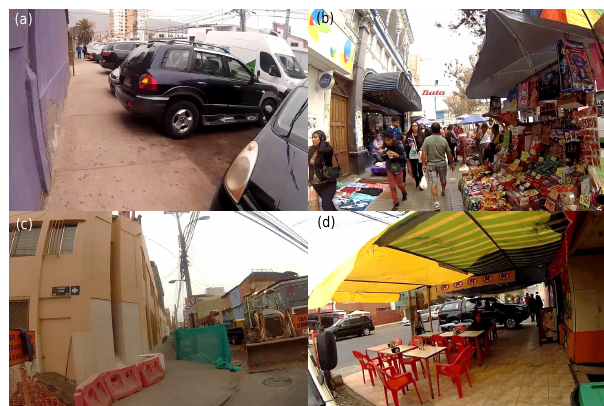
Figure 3. Still frames obtained from field recordings in the city Iquique: improperly parked vehicles (a) , informal commerce (b) , road repairs (c) , and restaurant tables on the sidewalk (d)